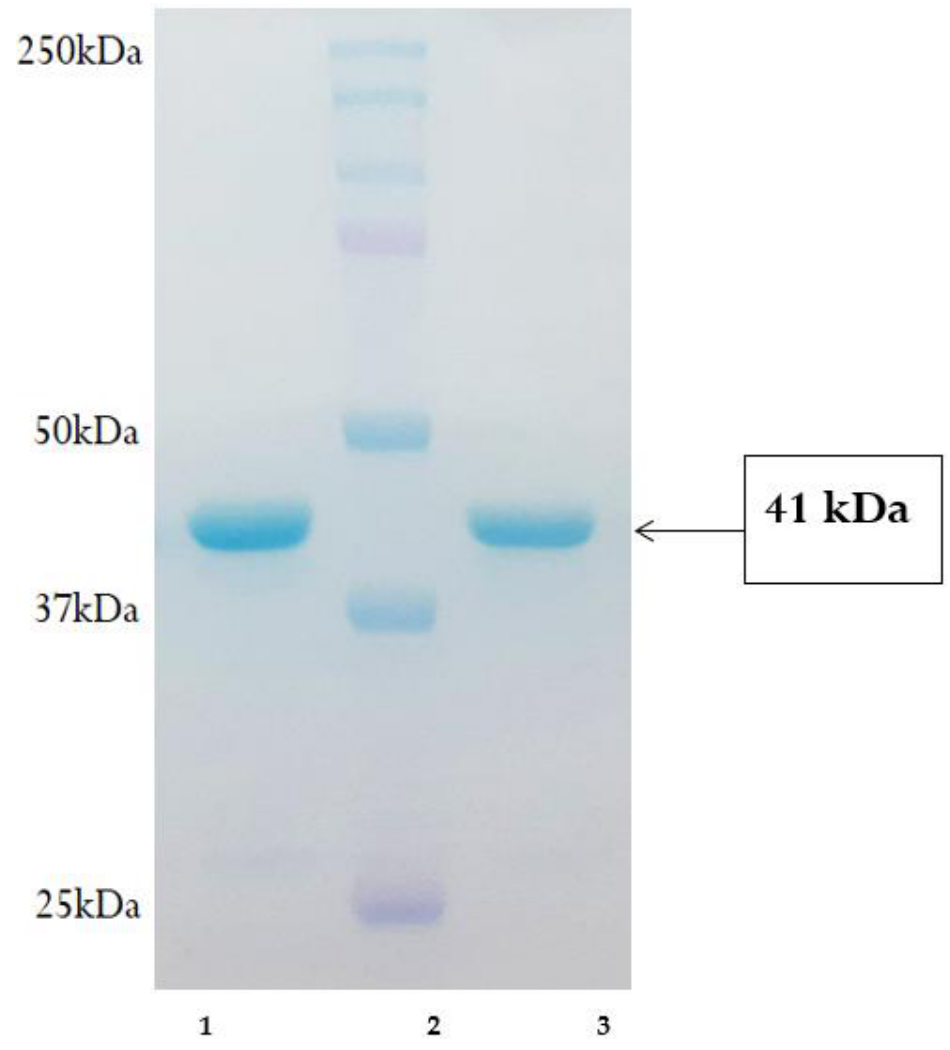
Figure 3. SDS-PAGE of recombinant iturin A. ( Lane 1 ) Protein sample, ( Lane 2 ) protein mol. wt marker (25 to 250 kDa), ( Lane 3 ): protein sample.